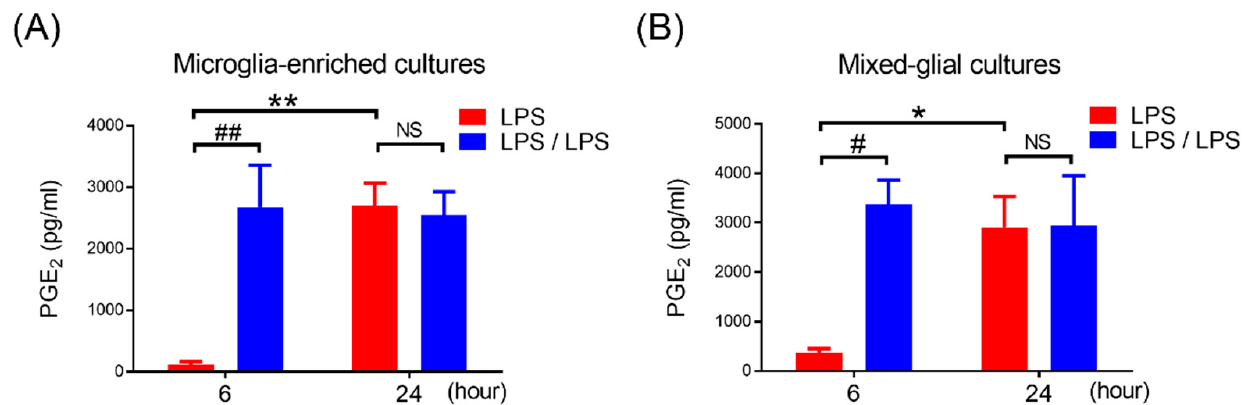
Figure 2. Failure of PGE 2 reduction in microglia-enriched and mixed glia cells with endotoxin toler- ance challenge. ( A , B ) A supernatant level of PGE 2 in microglia-enriched cultures ( A ) and mixed glia cultures (MG) containing 80% astroglia and 20% microglia ( B ) in LPS-treated and LPS/LPS-treated regimen were detected at 6 and 24 h after treatment by ELISA. Five independent experiments were performed in duplicate. Data are expressed as the mean ± SEM, * p < 0.05, ** p < 0.01 vs. 6H; # p < 0.05, ## p < 0.01 vs. LPS. NS: no significant differences.